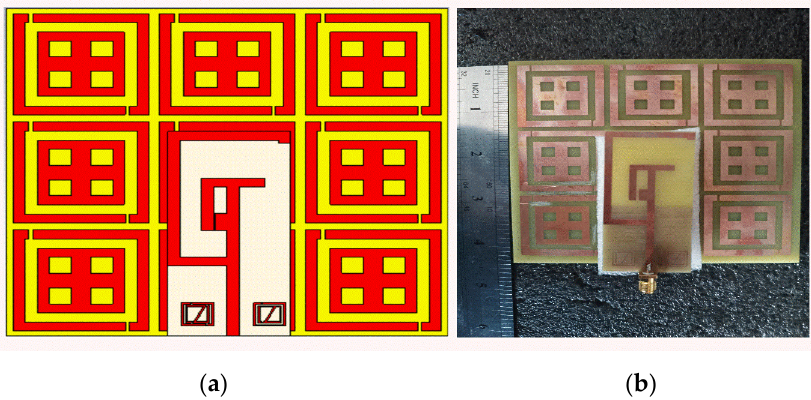
Figure 12. Prototype AMC Backing Antenna ( a ) Antenna top view ( b ) Fabricated Antenna.